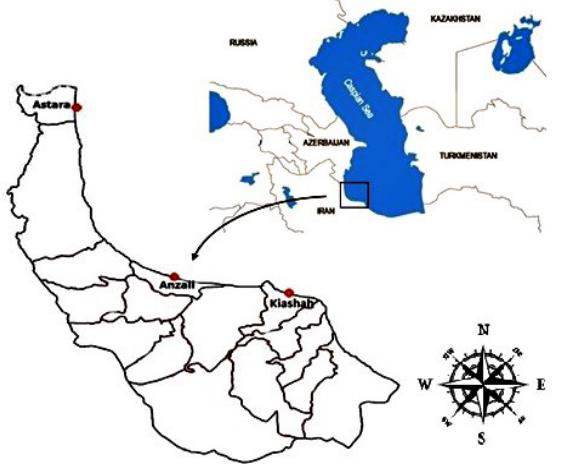
Figure 1. The locality of fish sampling stations in the South Caspian Sea